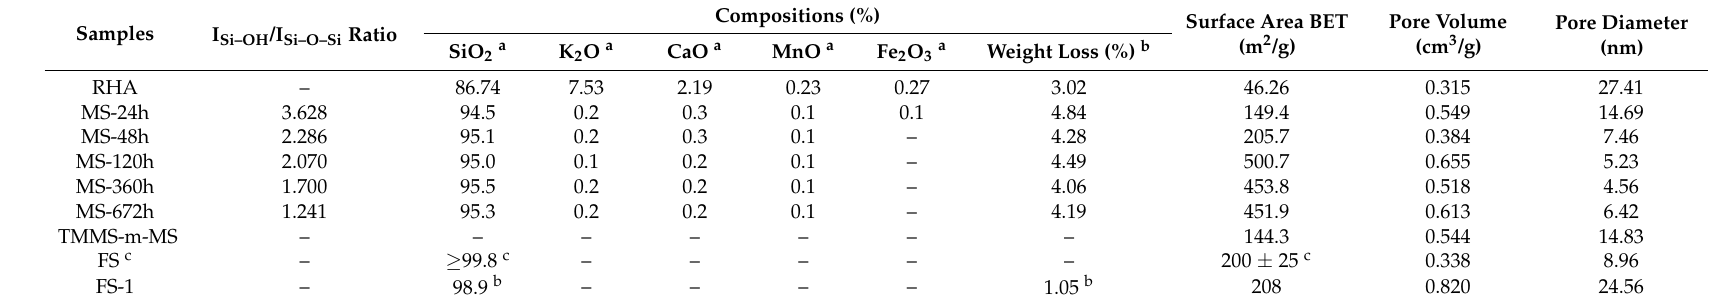
Table 1. Textural characteristics of starting silica, mesoporous silica materials, surface-modified silica materials and fumed silica.